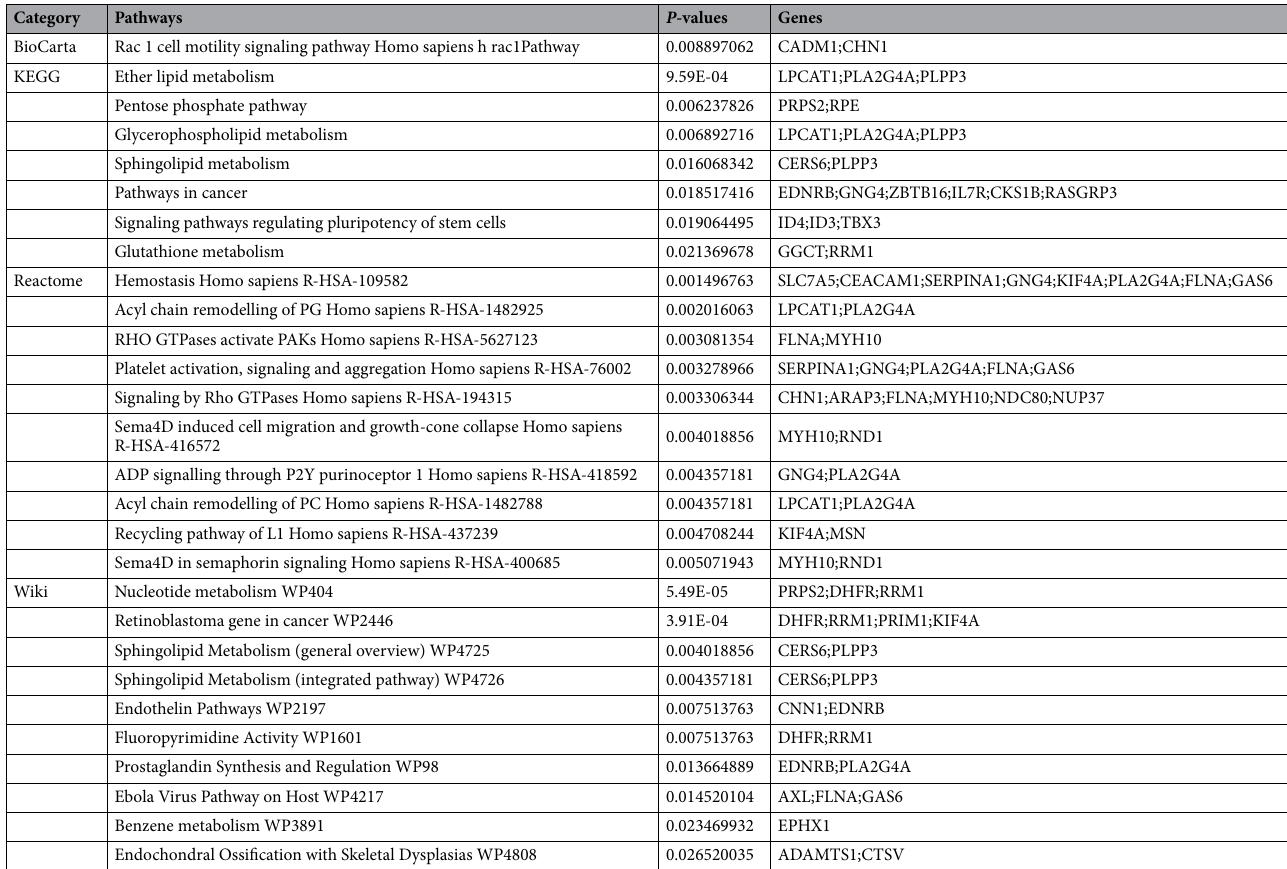
Table 3. Analysis of pathway enrichment among IPF, COVID-19, SCLC, NSCLC, and CRC lung